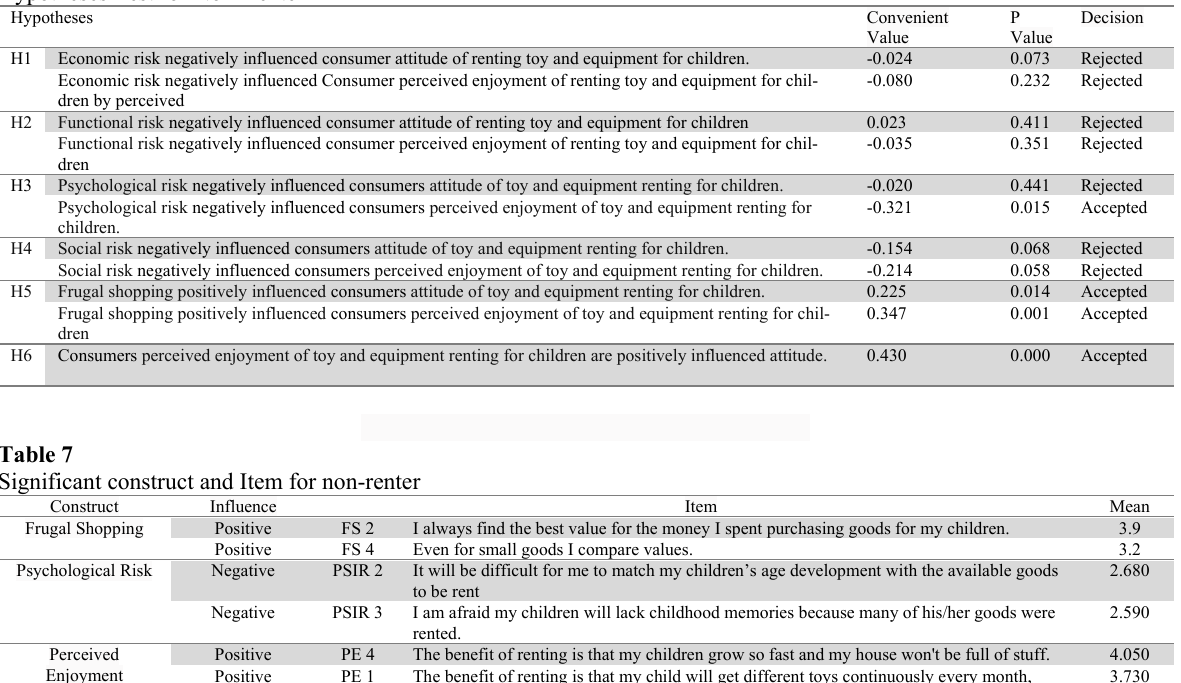
Significant construct and Item for non-renter Construct Influence